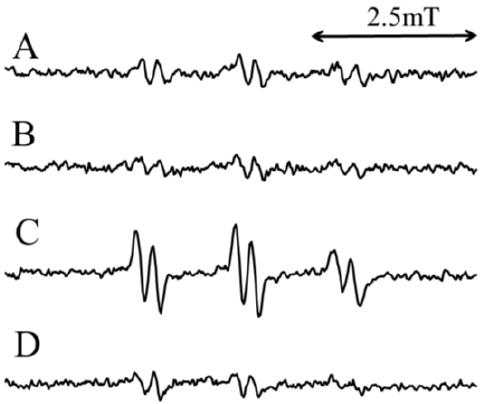
Figure 1. ESR spectra of the standard reaction mixture (I) irradiated with visible light at 436 nm. ( A ) Standard H O reaction mixture (I); ( B ) Standard H 2 2 mM CA; ( C ) Standard D O reaction mixture (I); ( D ) Standard D 2